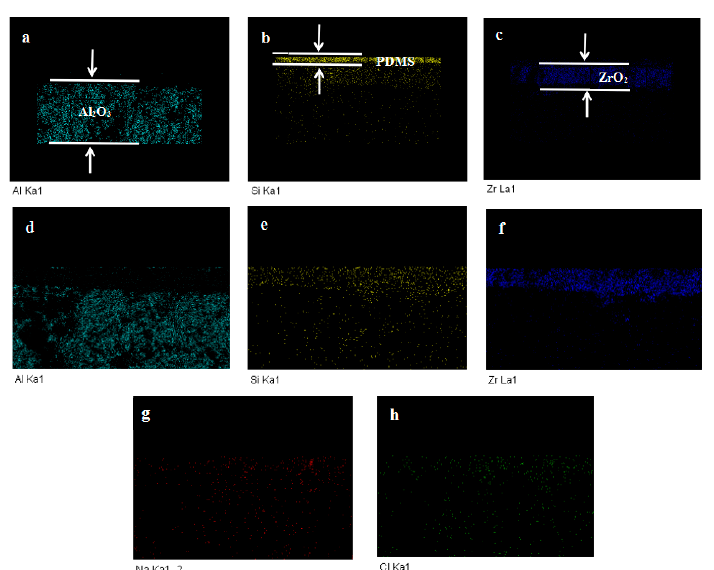
Figure 6. SEM–EDX images of cross-sectional components of the virgin membrane ( a – c ) and fouled membrane ( d – h ).